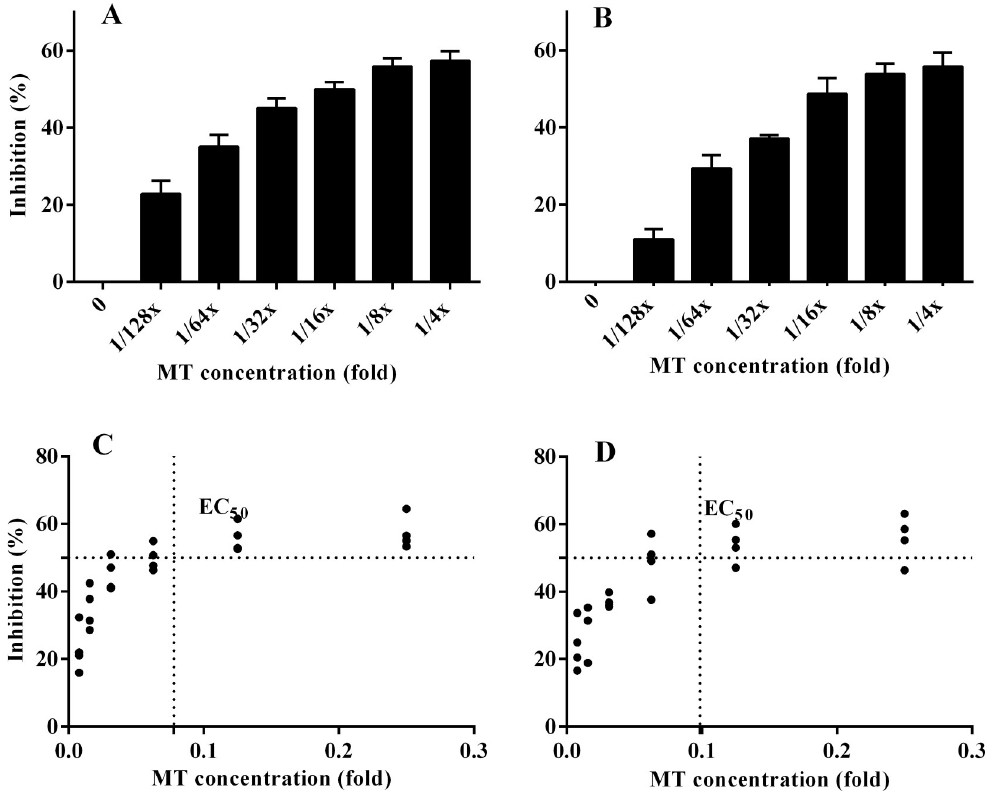
Fig 5. Impacts of treatment on S . Typhimurium biofilms. The figures demonstrated a concentration-dependent inhibition of S . Typhimurium (ATCC 14028) (A) and LVPP-STI15 (B) biofilm formation in the presence of a combination of methyl gallate (MG) and tylosin (Ty) (MT) with an initial concentration of ¼× MT (32 μ g/mL MG and 64 μ g/mL Ty). The EC 50 of MT in S . Typhimurium (ATCC 14028) (C) and LVPP-STI15 (D) biofilms were calculated by considering 0% and 100% as minimal and maximal biofilm inhibition, respectively. Values represent mean ± SEM of four independent experiments.